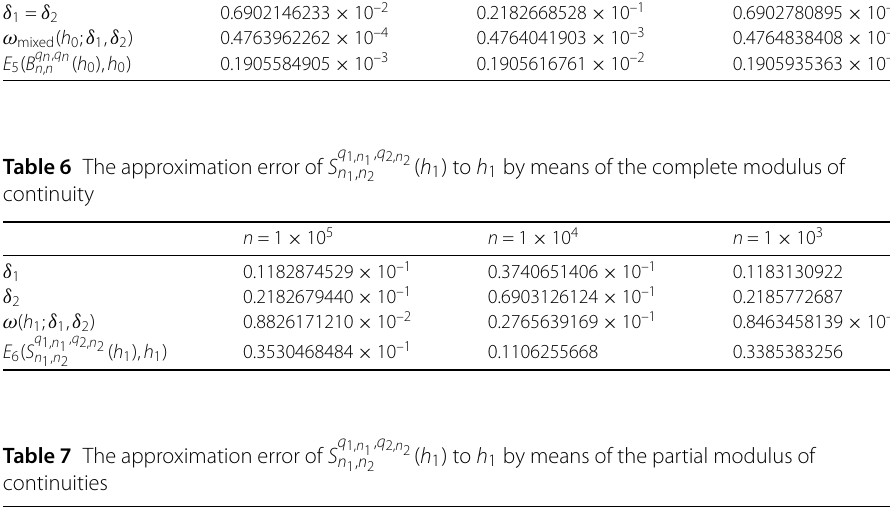
Table 7 The approximation error of S